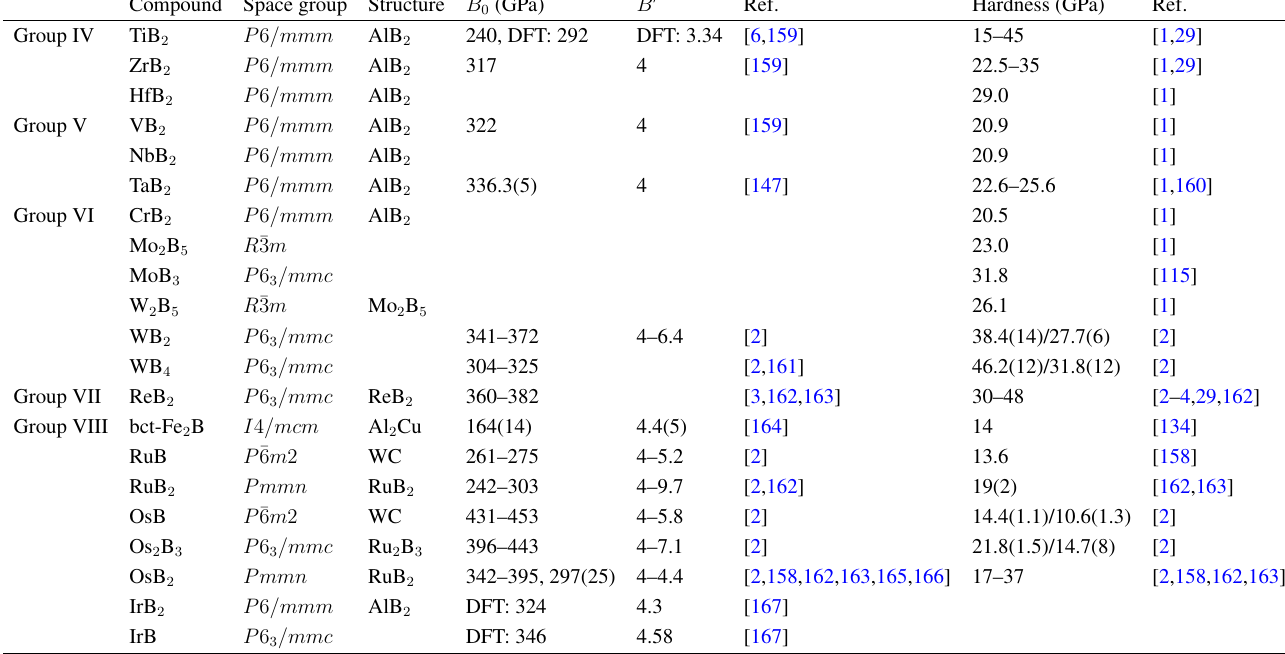
Table 3. Properties of selected transition metal borides. B pressure